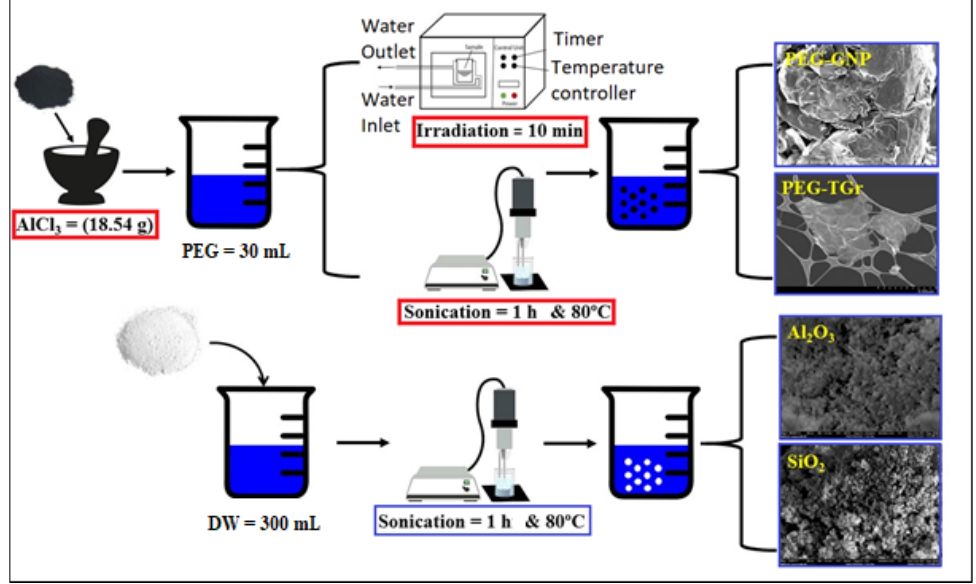
Figure 1. Schematic illustration for the different nanofluids preparation process.